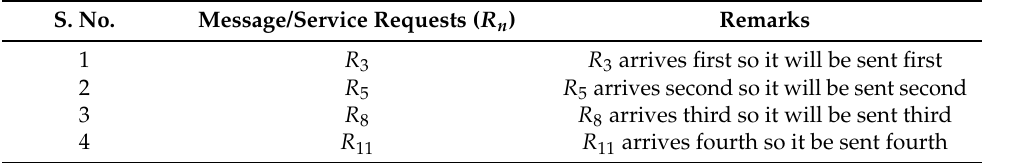
Table 4. FCFS basis scheduling algorithm